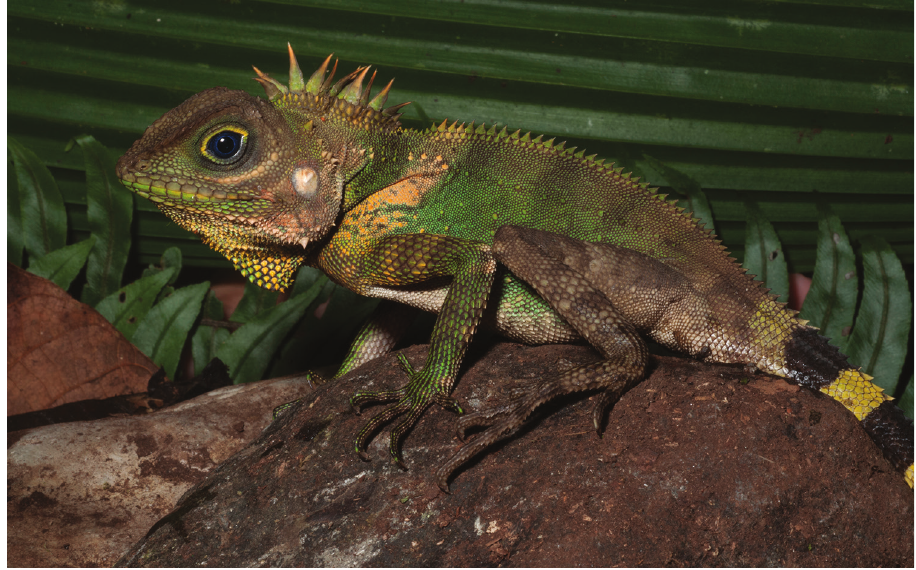
Figure 43. Gonocephalus cf. interruptus male (KU 334325) from Mt. Lumot, Municipality of Gingoog, Misamis Oriental Province. Photo: